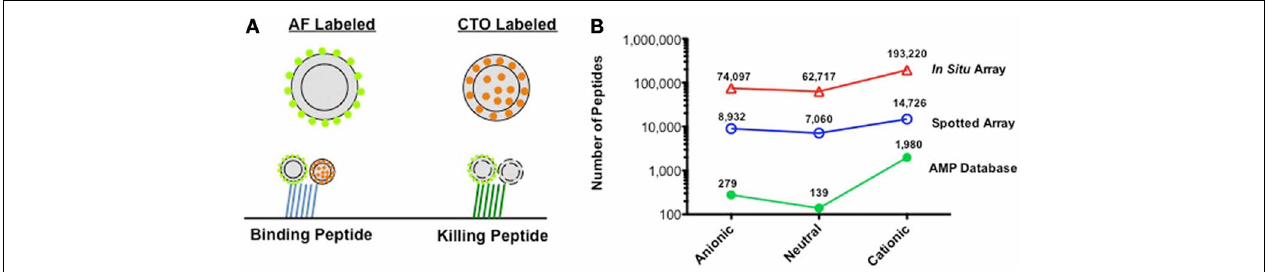
FIGURE 1 | (A) Activity based bacterial screening to identify peptides that bind and those that kill a specific pathogen. AF, AlexaFluor-555; CTO, Cell-Tracker Orange. (B) Number of peptides based on net charge for AMPs